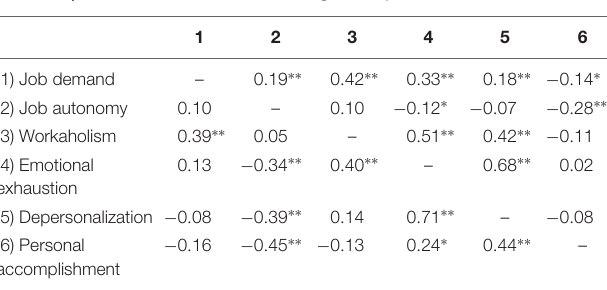
TABLE 4 | Correlation table – manufacturing